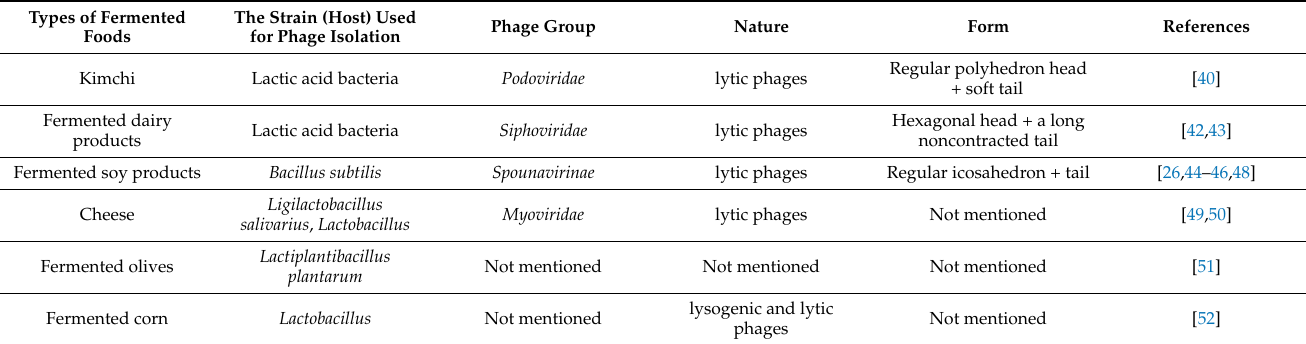
Table 1. Phages isolated from fermented foods in the past ten years.